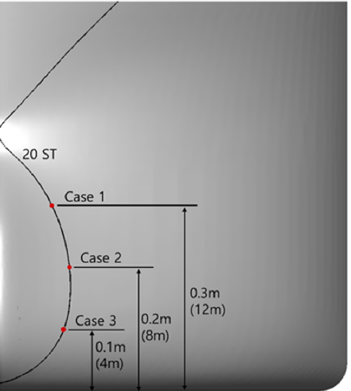
Figure 7. Grid shape for Japan bulk carrier (JBC) resistance calculation. ( a ) whole domain (side view), ( b ) surface mesh of fore body (side view).